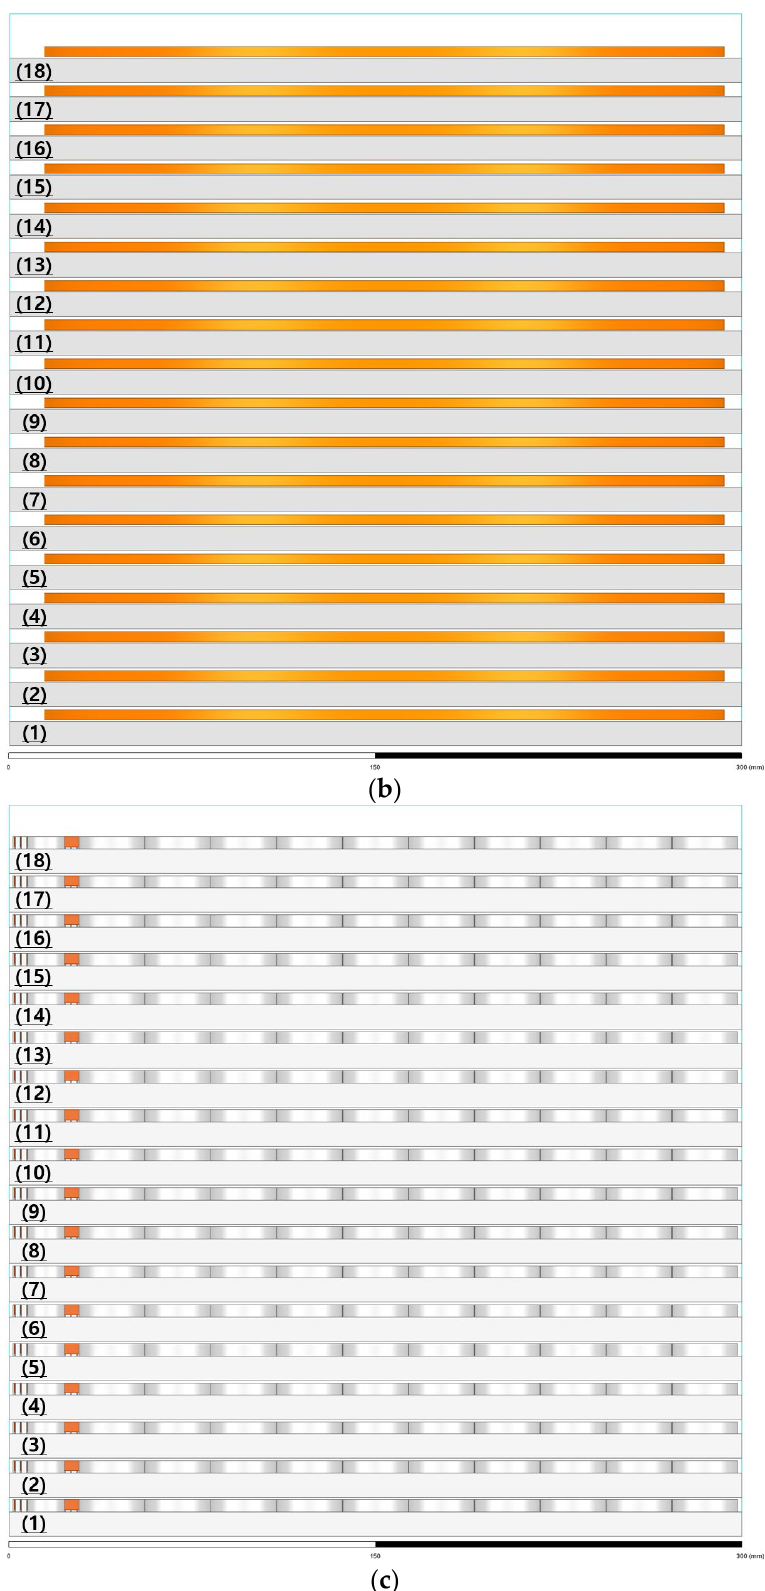
Figure 11. A complete superconducting module that consists of the same module of each type with the free space of each winding method in the standard box: ( a ) helical type, ( b ) spiral type, ( c ) meander type.